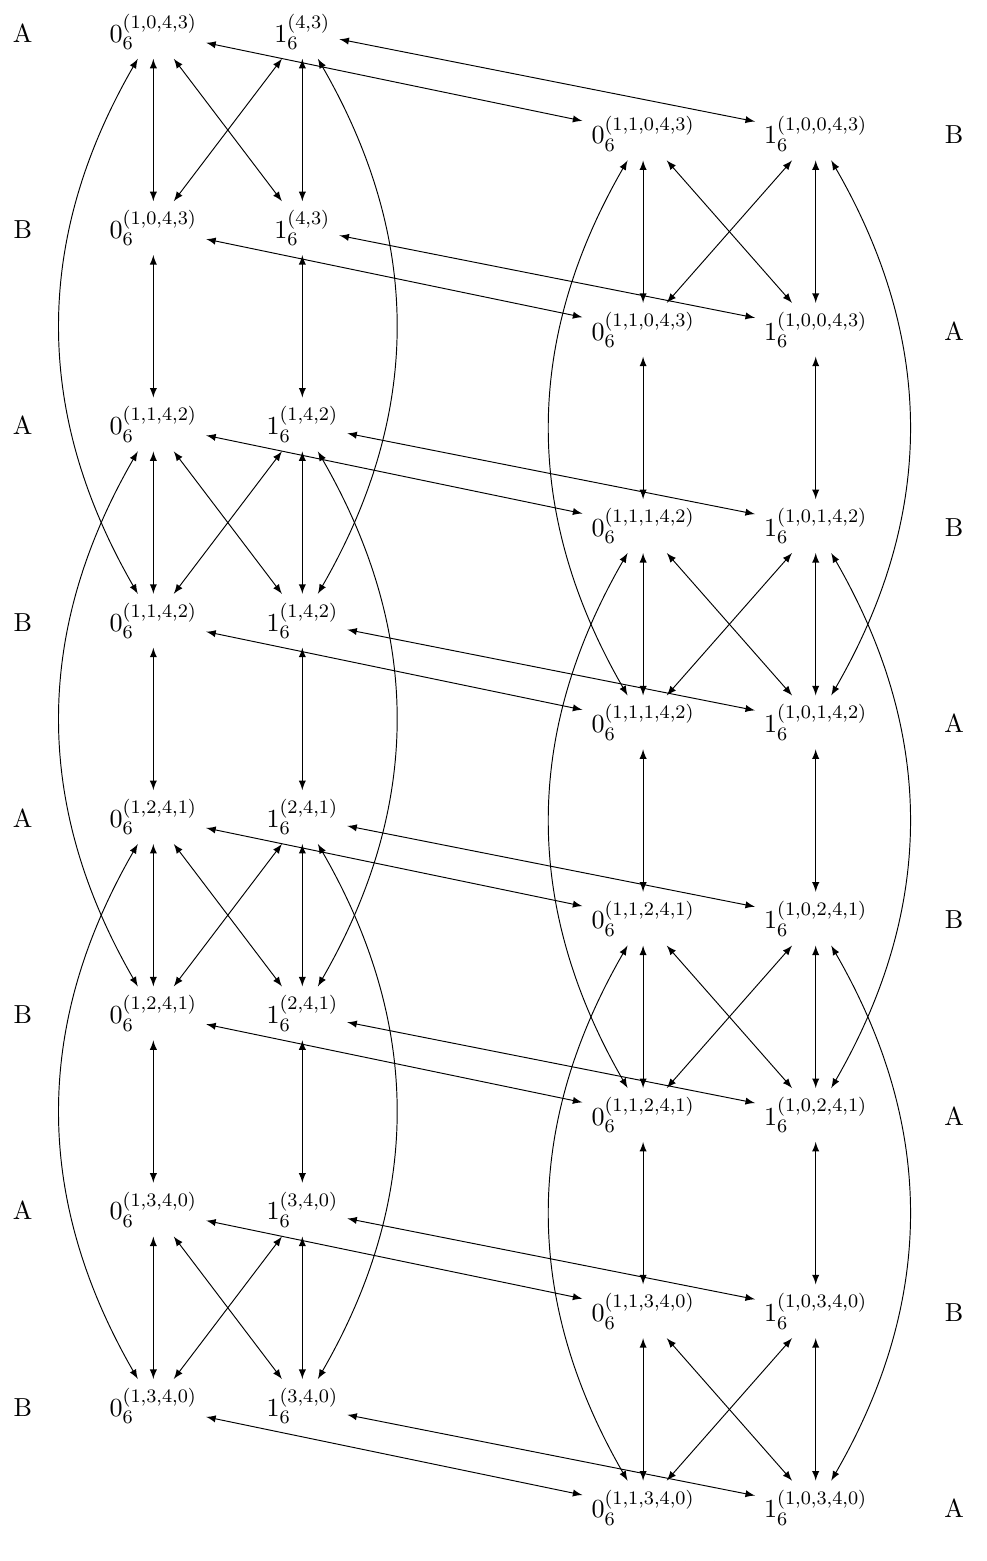
Figure 13 . The T-duality orbit of the 1 (4 ; 3)